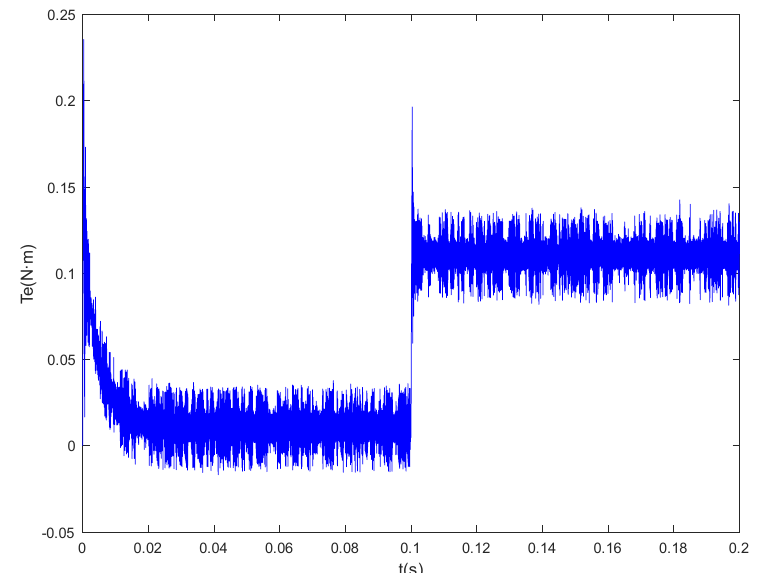
Figure 18. Curve of speed after sudden loading.